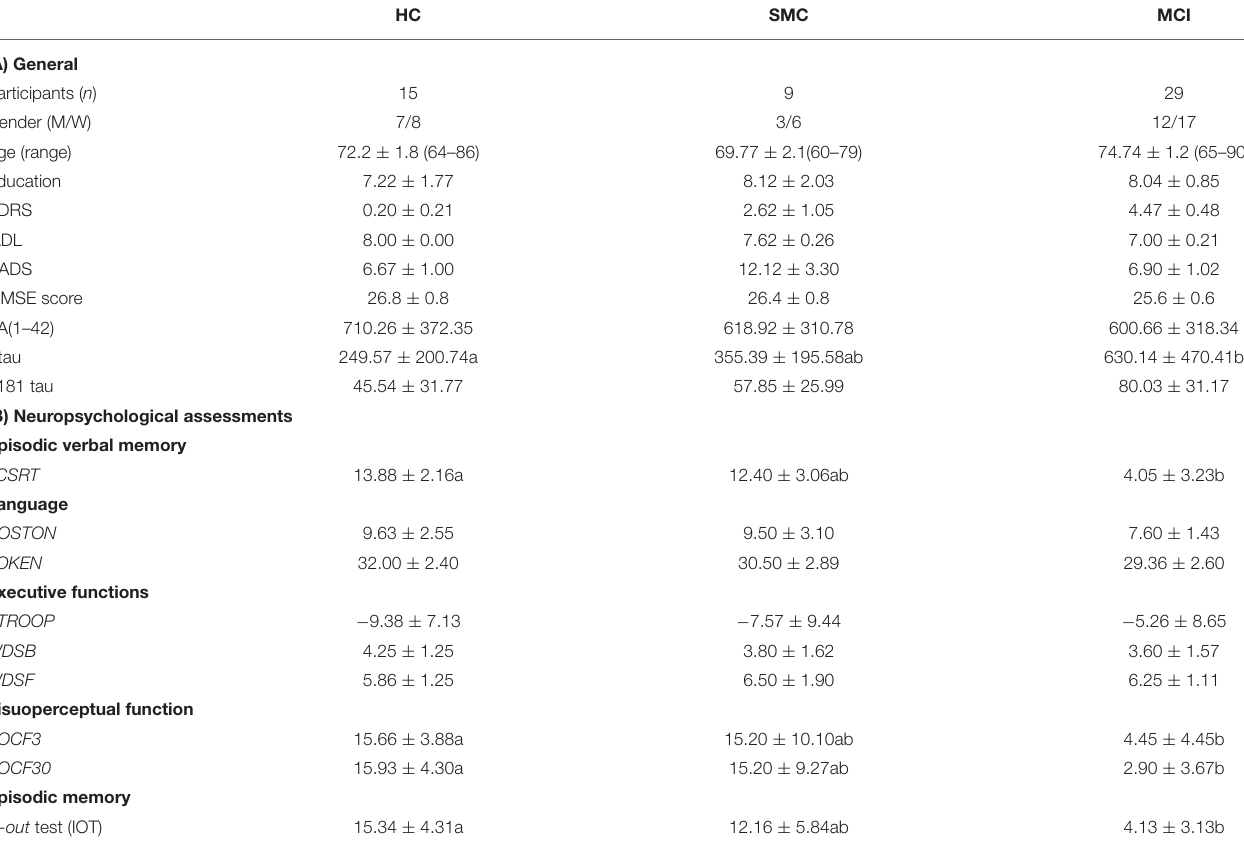
TABLE 1 | Cohort demographic, clinical and neuropsychometric